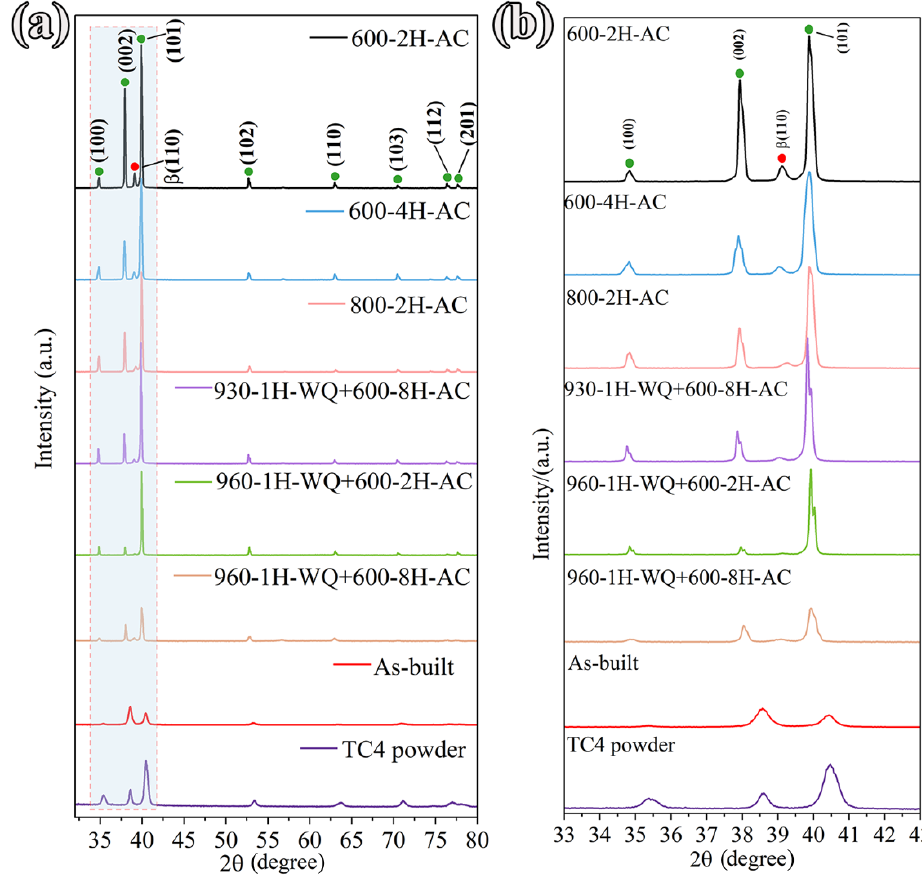
Figure 7. ( a ) XRD patterns of SLM TC4; ( b ) the enlarged inset of ( a ).